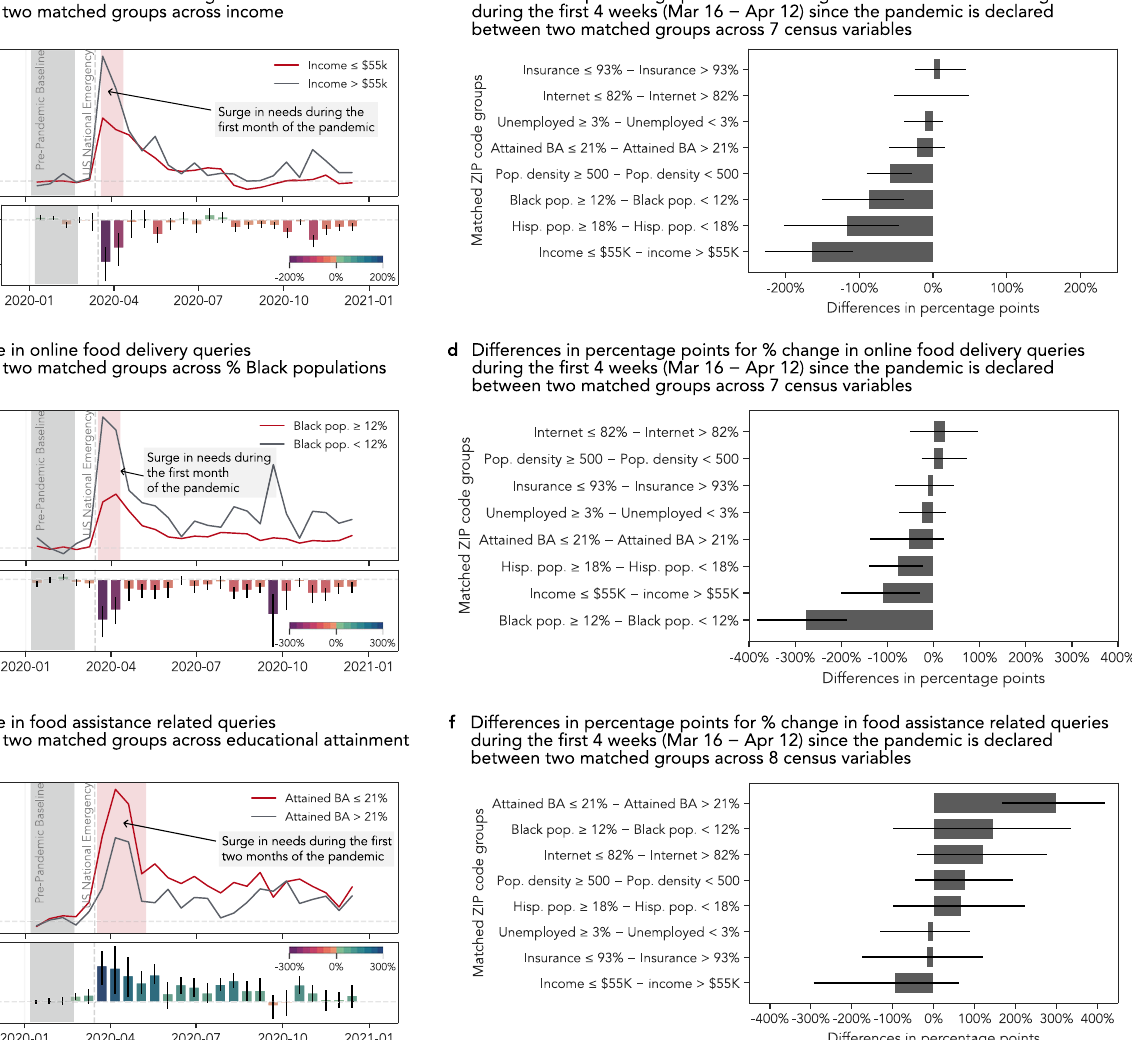
residents or lower income experienced a smaller change in online food delivery services during the fi rst month of the pandemic. e Food assistance-related queries were also in high demand with an over 400% increase at the beginning of the pandemic. f ZIP codes with lower educational attainment experienced a greater change in food assistance-related queries than ZIP codes with higher educational attainment. In all bar charts in a – f , data are presented as mean values, and error bars indicate 95% con fi dence intervals (1603 ≤ n ≤ 12,575, Supplementary Table 6 for sample sizes per SDoH factor). Both mean values and con fi dence intervals are obtained through bootstrapping with 500